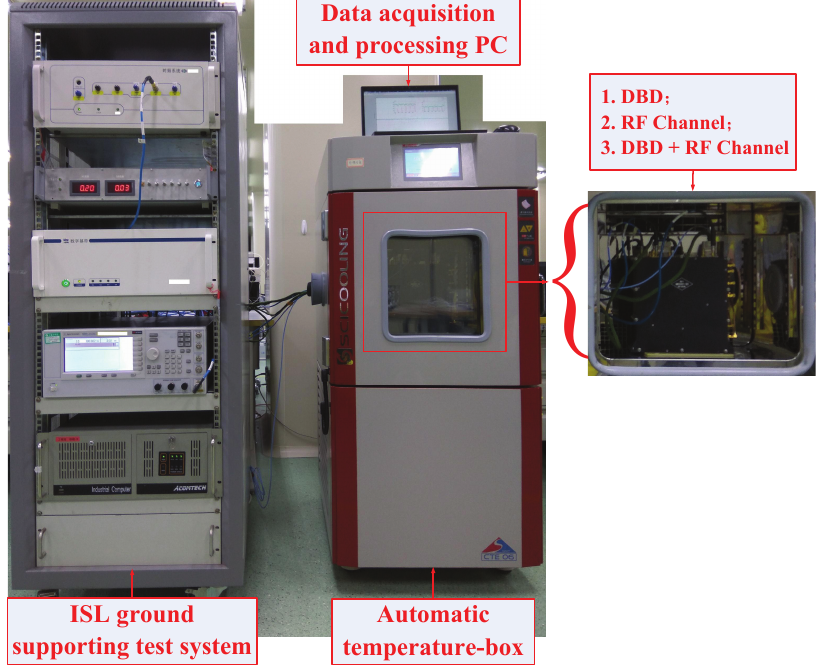
Figure 6. Test scenarios of the field data collection and ranging